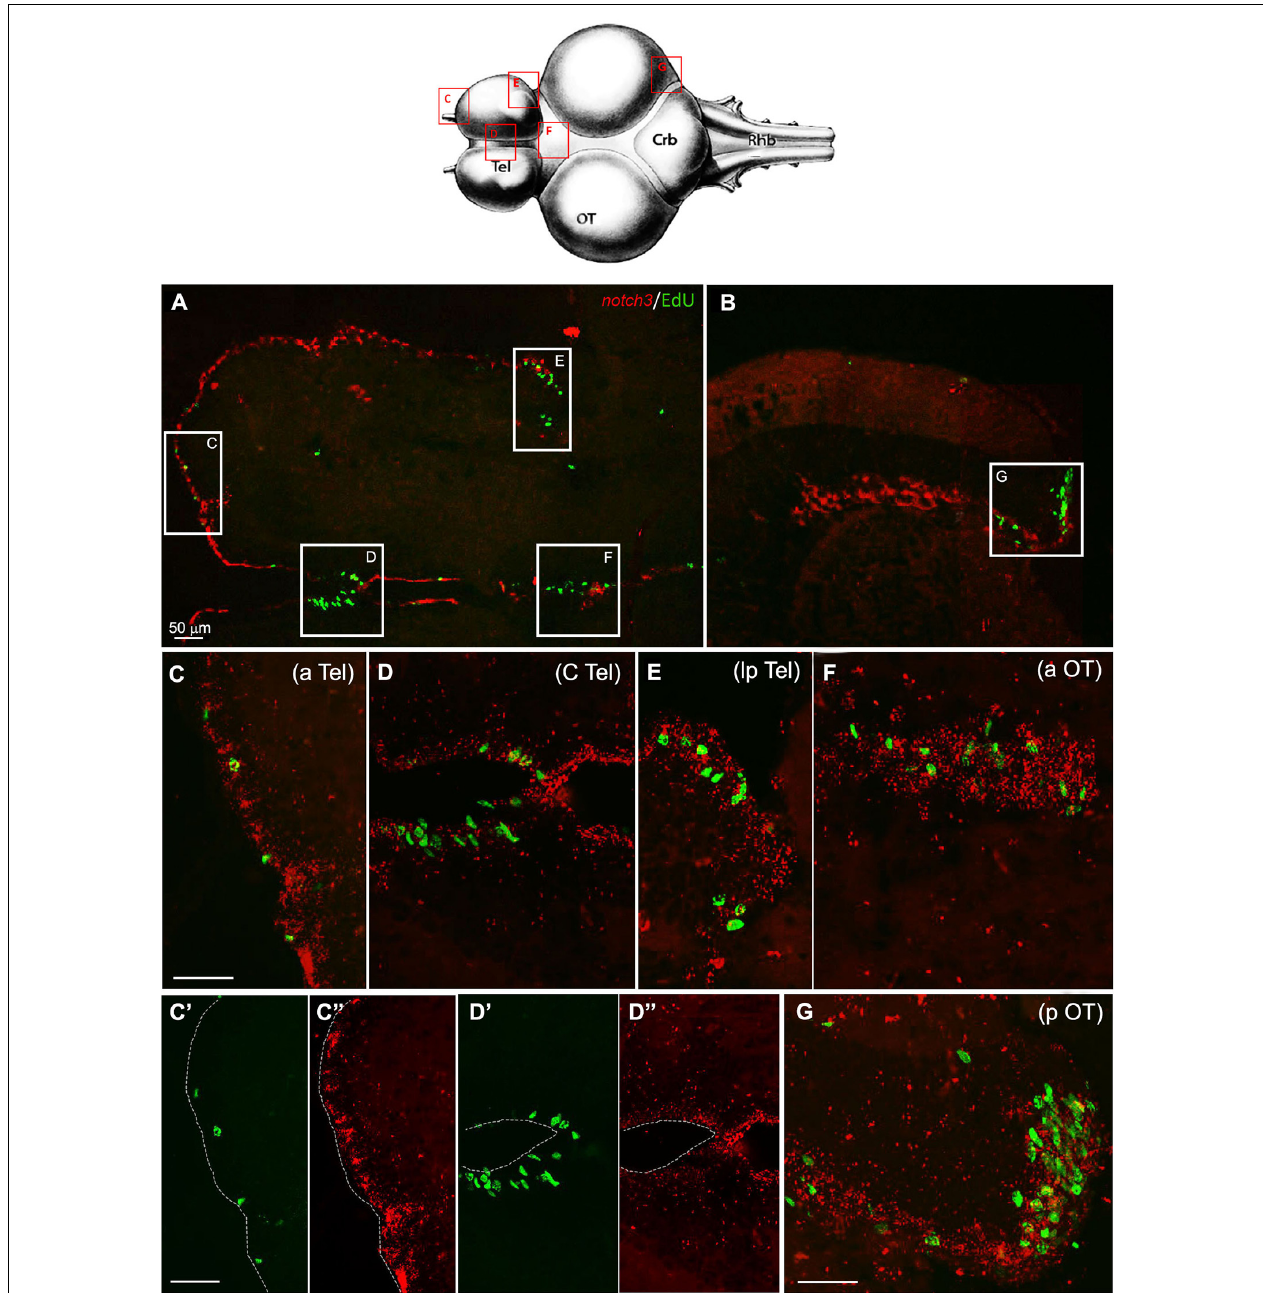
FIGURE 6 | Notch3 expression in proliferative niches of 7 weeks-old N. furzeri brain: (A) Overview of the brain in horizontal medial section (along the dorso/ventral axis) double-stained for EdU in green (labelling S-phase cells) and notch3 in red (by ISH). White frames show the areas magnified in (C–G) , representing respectively the anterior (aTel), central (cTel), latero-posterior Telencephalon (lpTel), the anterior (aOT) and posterior (pOT) Optic Tectum regions - In (C’)/(C”) and (D’)/(D”) green and red separated channel are shown for the two regions in (C,D) - Scale bars always represent 50 µ m and are indicative for all further images without specific scale bar indication. Footprint (modified from D’angelo, 2013–Atlas) represents the horizontal overview of the whole killifish brain; red-squared areas indicate the position of the figure panels, based on the corresponding letters. White arrows show the presence of double-stained Edu + / notch3